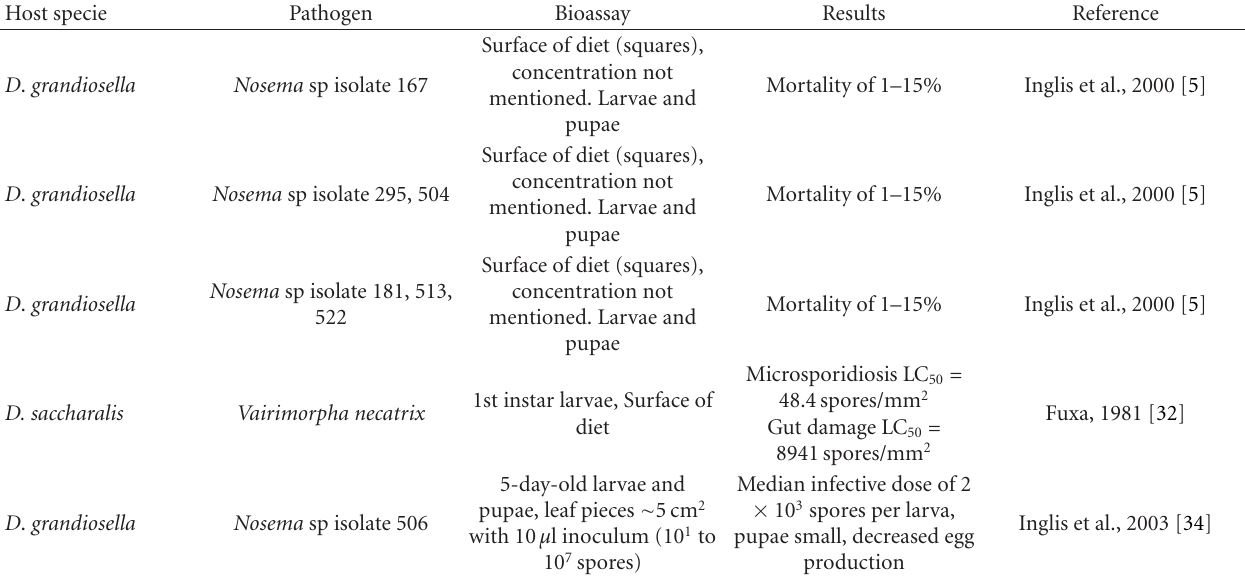
Table 3: Entomopathogenic-microsporidia bioassays on Diatraea